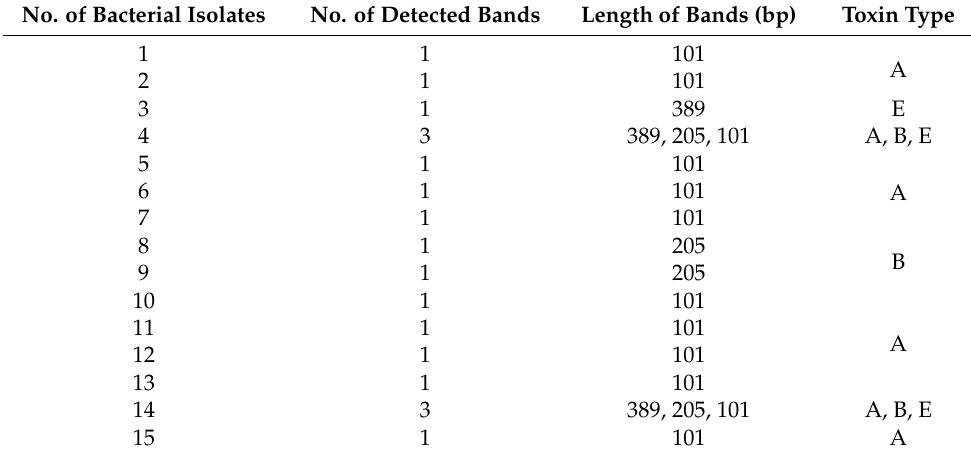
Figure 5. Ethidium bromide-stained 1.5% agarose gel with multiplex PCR products showed C. botulinum neurotoxin genes from seven bacterial isolates from the Gharbia governorate (lanes 1–7), where M represents a 1500 bp DNA ladder. Table 4. The banding pattern for the 15 studied bacterial isolates (isolated from the Alexandria governorate) using multiplex